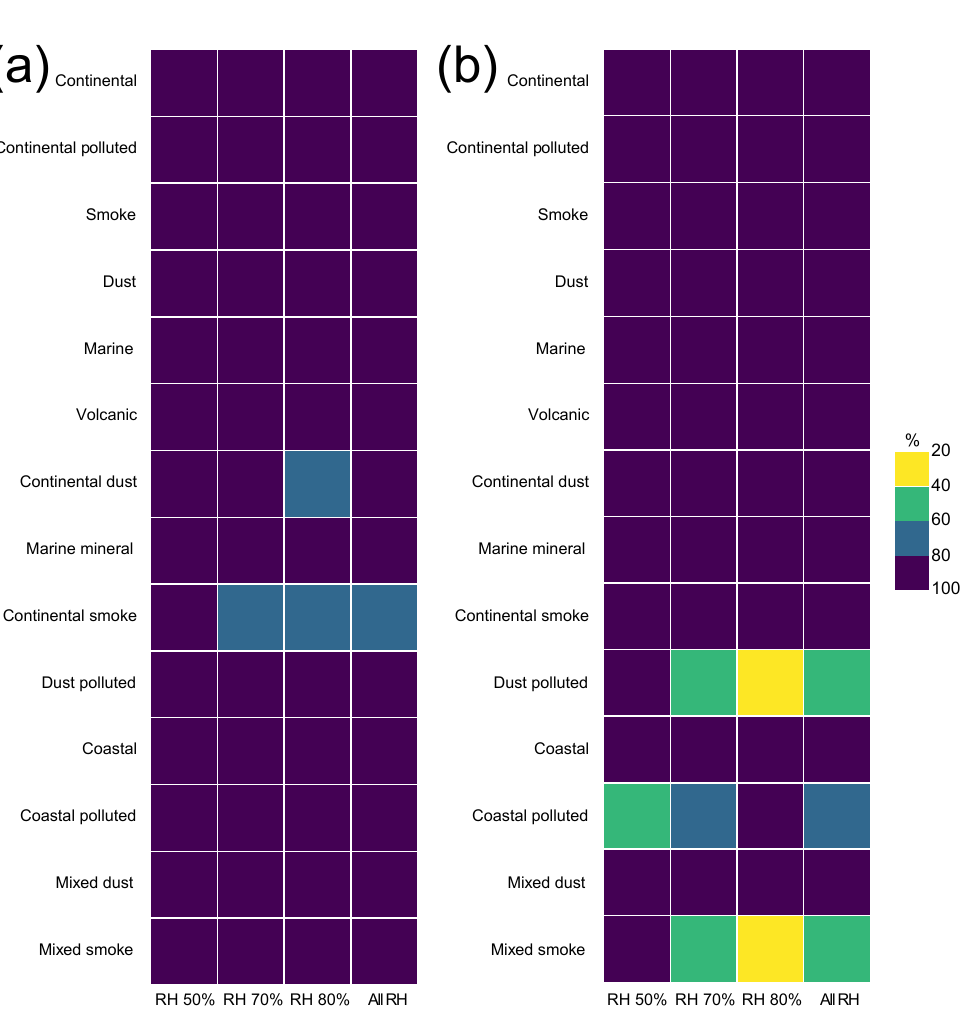
Figure 8. Performances of the ANNs for different relative humidity values (i.e. 50%, 70%, 80%) for (a) high-resolution typing and (b) low- resolution typing. The intervals of ANN confidence levels are shaded according to